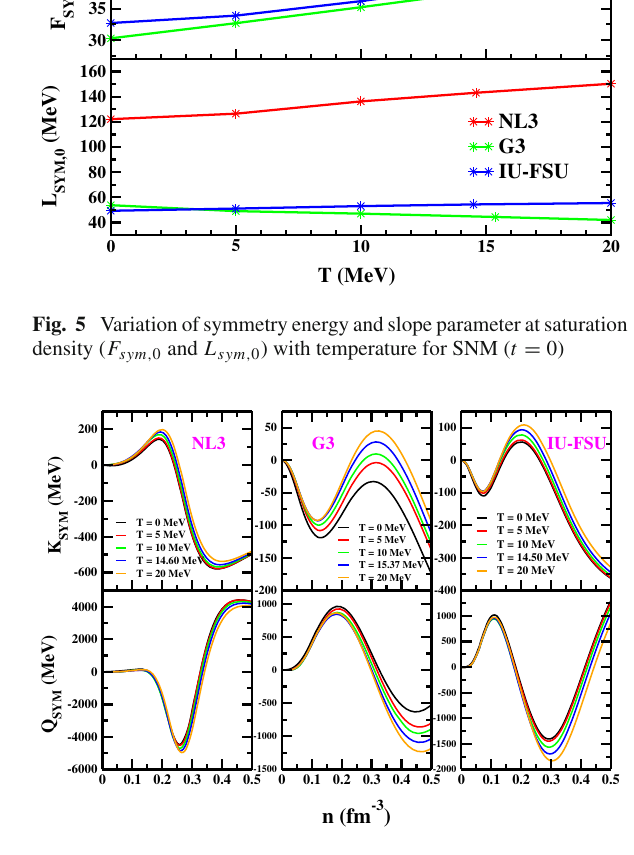
both the parameter sets.